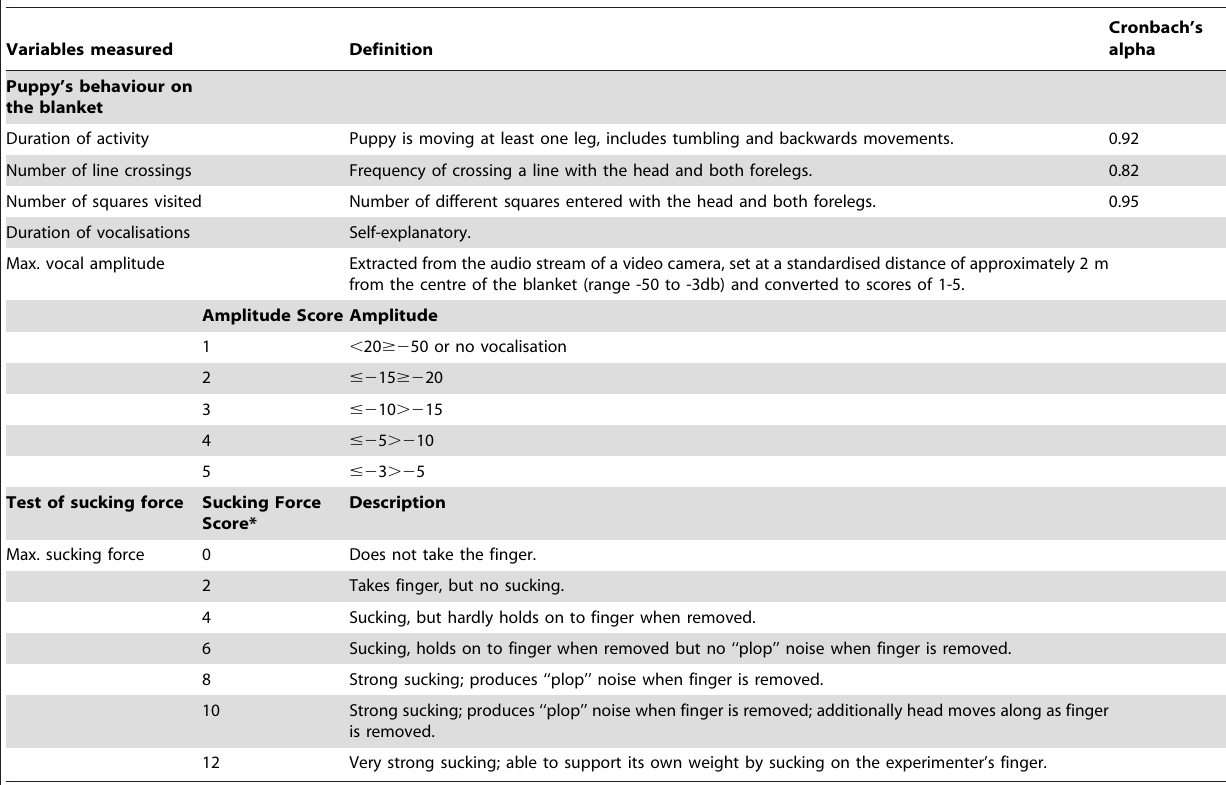
Table 2. Variables measured in the neonate test.